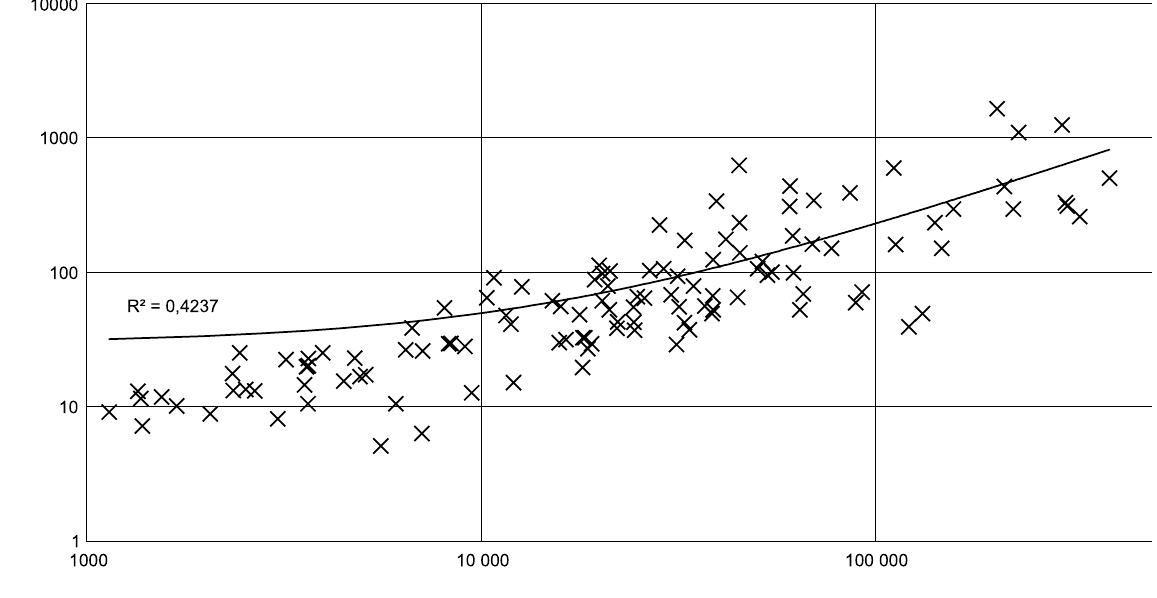
Fig. 8. Distribution of 119 urban areas